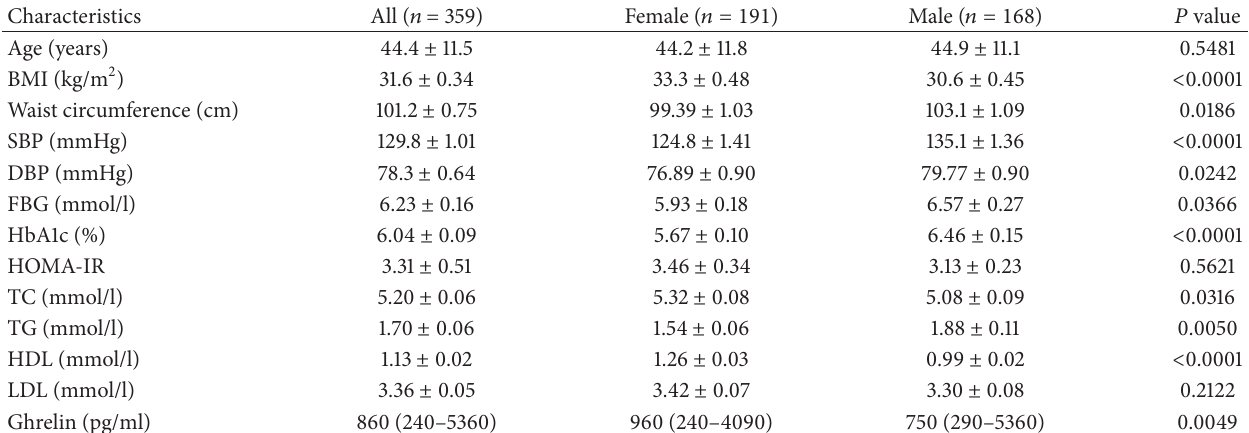
Table 1: Clinical and sociodemographic characteristics of the study population.